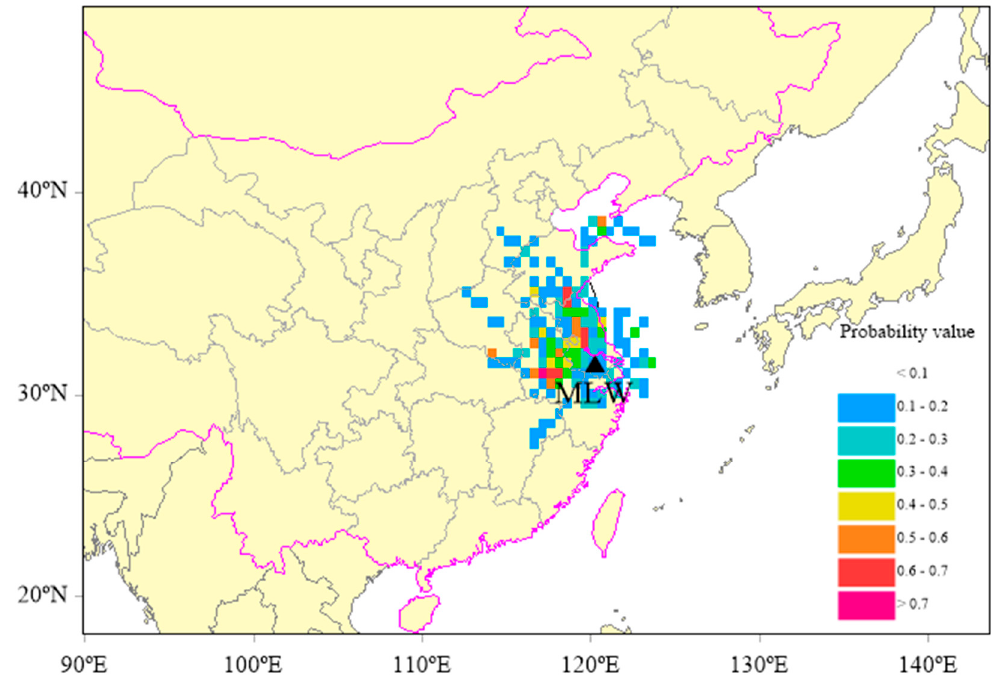
Figure 3. Spatial distribution of the potential source region contributions simulated for December 2014.